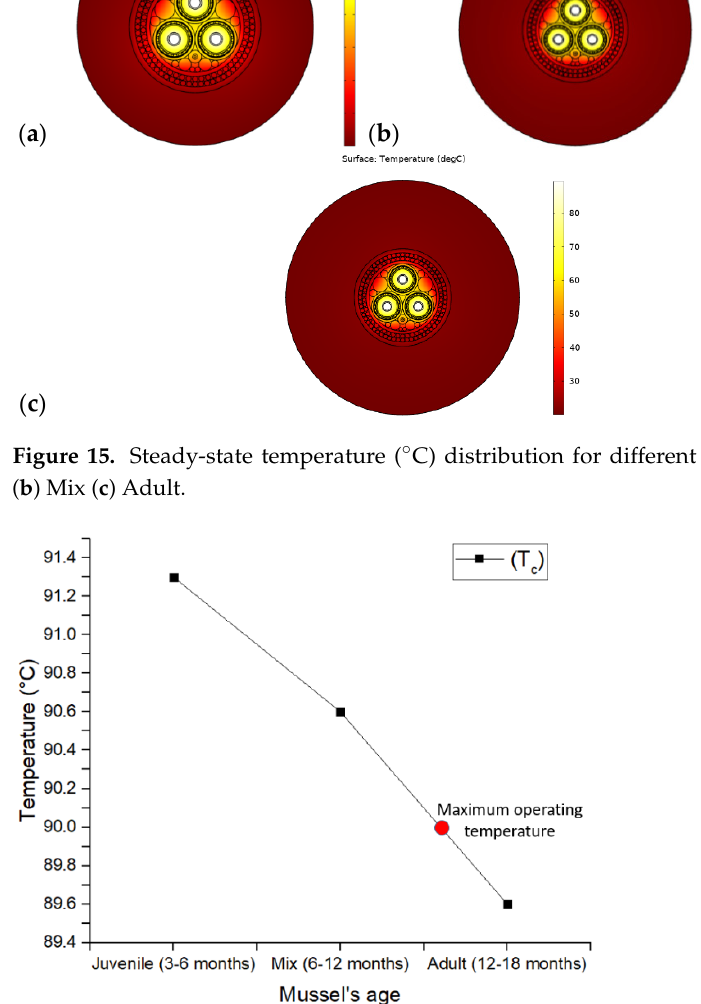
Figure 15. Steady-state temperature (°C) distribution for different ages of mussels ( a ) Juvenile, ( b ) Mix ( c ) Adult.